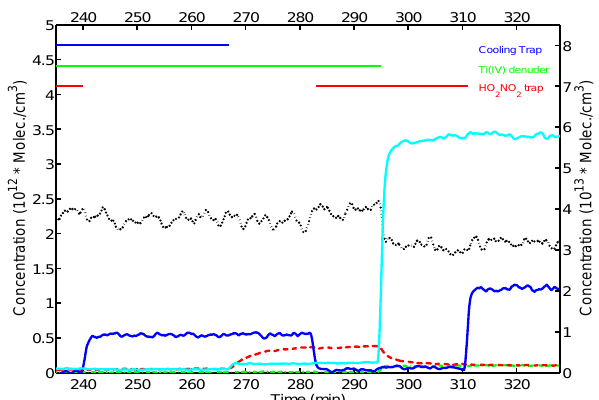
Fig. 2. Time traces of HO 2 NO 2 (blue solid line, left axis) and the by-products NO 2 (black dotted line, left axis), HONO (green dash dotted line, left axis), HNO 3 (red dashed line, left axis), and H 2 O 2 (turquoise solid line, right axis). Times at which traps were active are indicated by horizontal bars: Red: HO 2 NO 2 trap (heating sys- tem), green: Ti(IV) denuder, blue: cooling trap. Concentrations are given without the dilution in front of the CWFT. The data were ob- tained at initial concentrations of 3 . 4 × 10 12 moleculescm − 3 NO 2 , 5 . 4 × 10 15 moleculescm − 3 O 2 , 1 . 6 × 10 16 moleculescm − 3 CO, and 2 . 36 × 10 18 moleculescm − 3 water